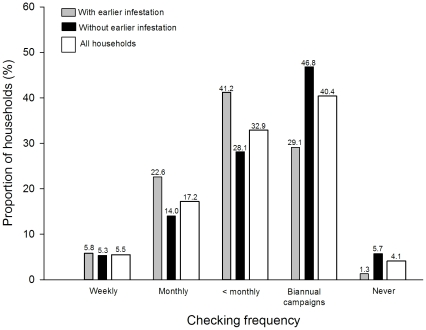
Head lice-checking frequencies.Checking frequencies in households with and without earlier head lice infestations as well as in all households combined. The exact proportion is written above each bar; n = 5791.